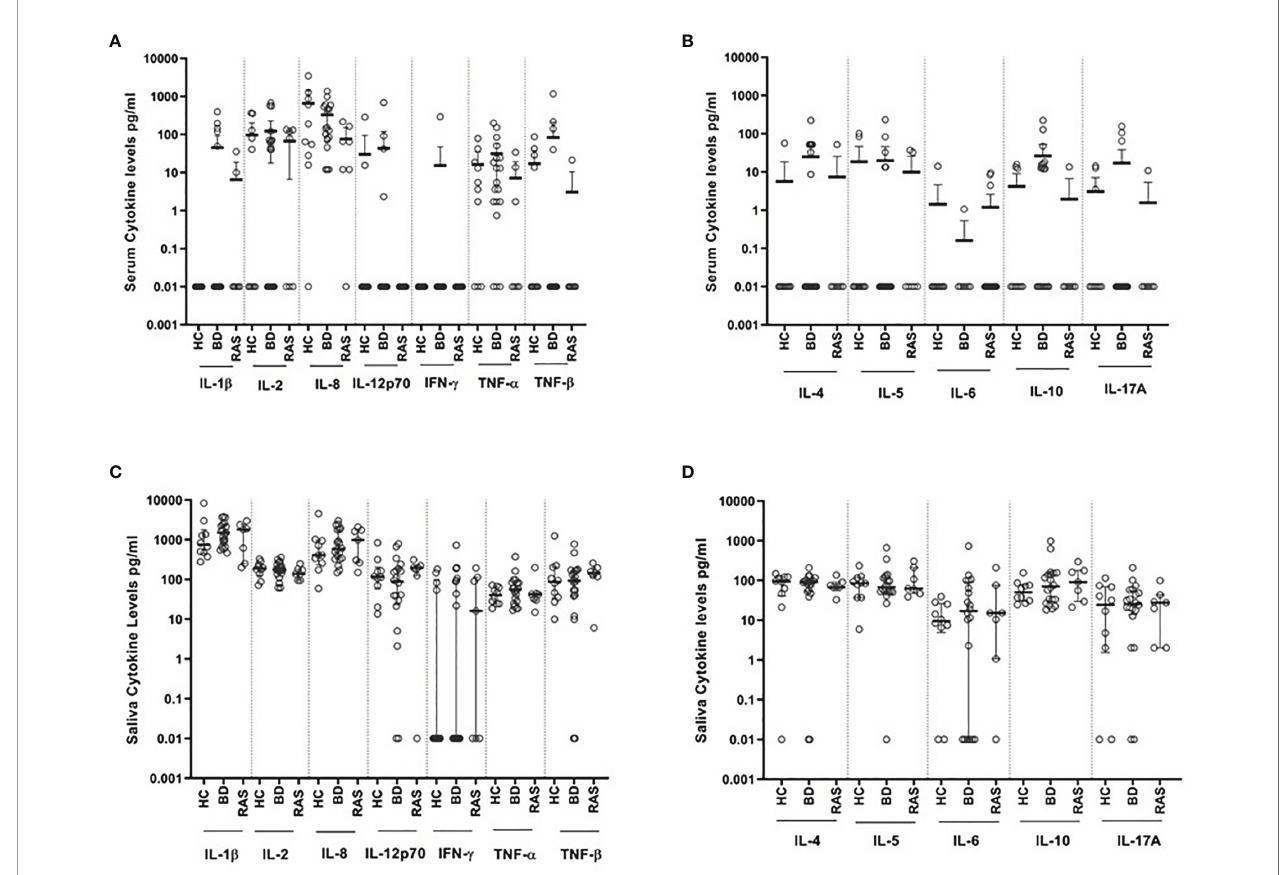
FIGURE 1 | Levels of cytokines (pg/ml) detected in saliva and serum from BD (N=20), RAS (N=7) and HC (N=10). (A) Serum Th1 cytokines and IL-8 chemokine, (B) Serum Th2 cytokines and IL-17A, (C) Saliva Th1 cytokines and IL-8 chemokine, (D) Saliva Th2 cytokines and